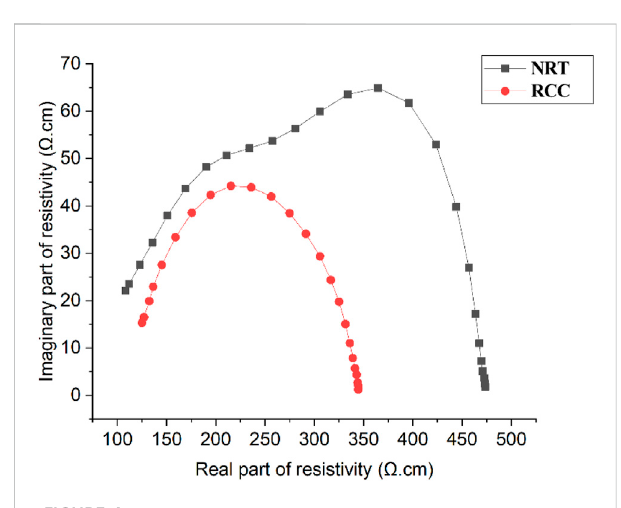
FIGURE 4 Cole – Cole curves of normal renal tissue (NRT) and renal cell carcinoma (RCC).